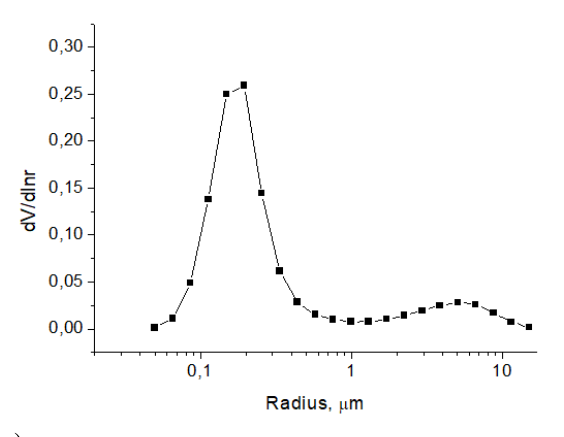
Figure 2. Comparison of average differences , 11 between algorithm without polarization and proposed algorithm with